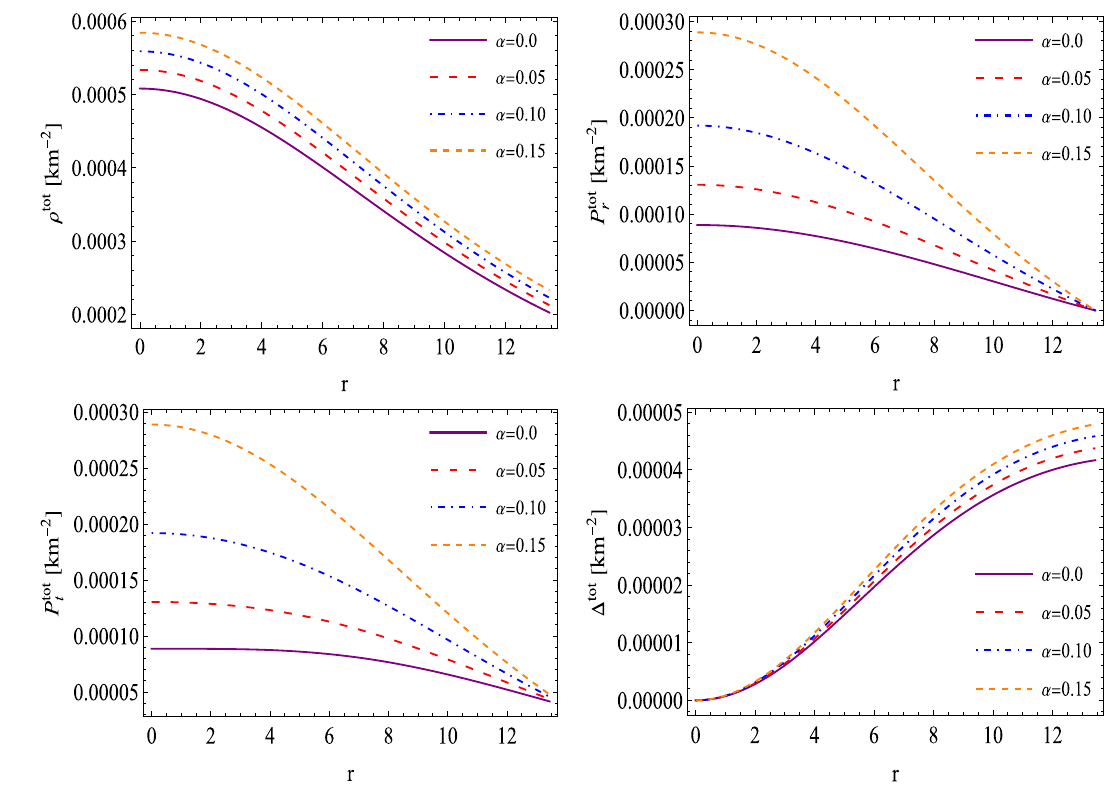
coordinate r withinthestellarobjectfordifferent α withconstantvalues